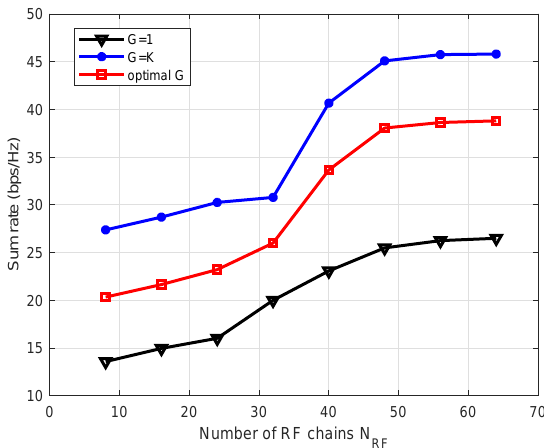
Figure 11. Sum-rate Vs number of RF chains. Number of users K = 8, number of transmit antennas N t = 64, and SNR = 10 dB.